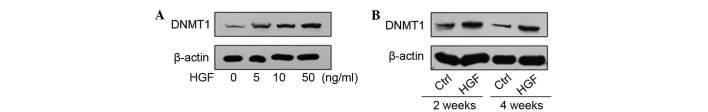
HGF upregulates DNMT1 protein levels. (A and B) Expression levels of DNMT1 in HL-7702 cells treated with HGF were analyzed by western blotting as a function of (A) dose and (B) time. HGF, hepatocyte growth factor; DNMT, de novo DNA methyltransferase; Ctrl, control.